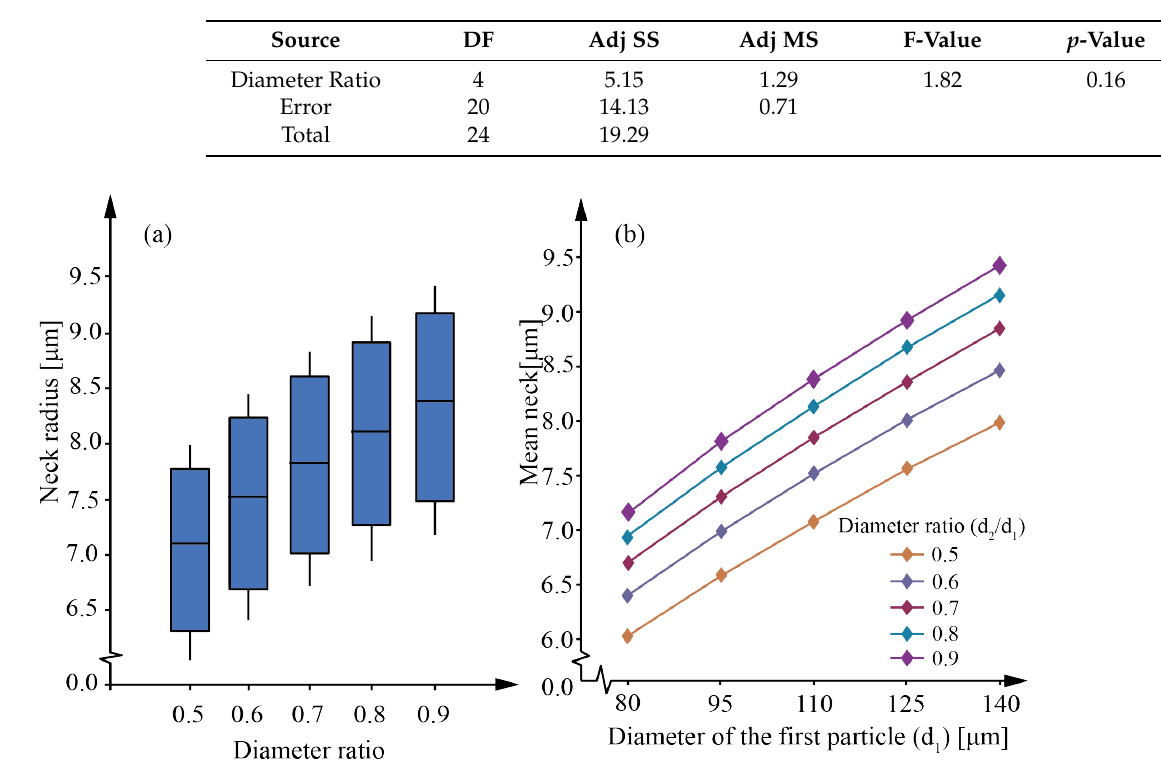
Figure 1. ( a ) Box plot of the neck radius obtained at different diameter ratios of the particle diameters. ( b ) Interaction plot for the two factors under consideration: diameter of the first particle (d 1 ) and diameter ratio (d 2 /d 1 ). Table 6. ANOVA of the influence of diameter ratio on the neck radius.